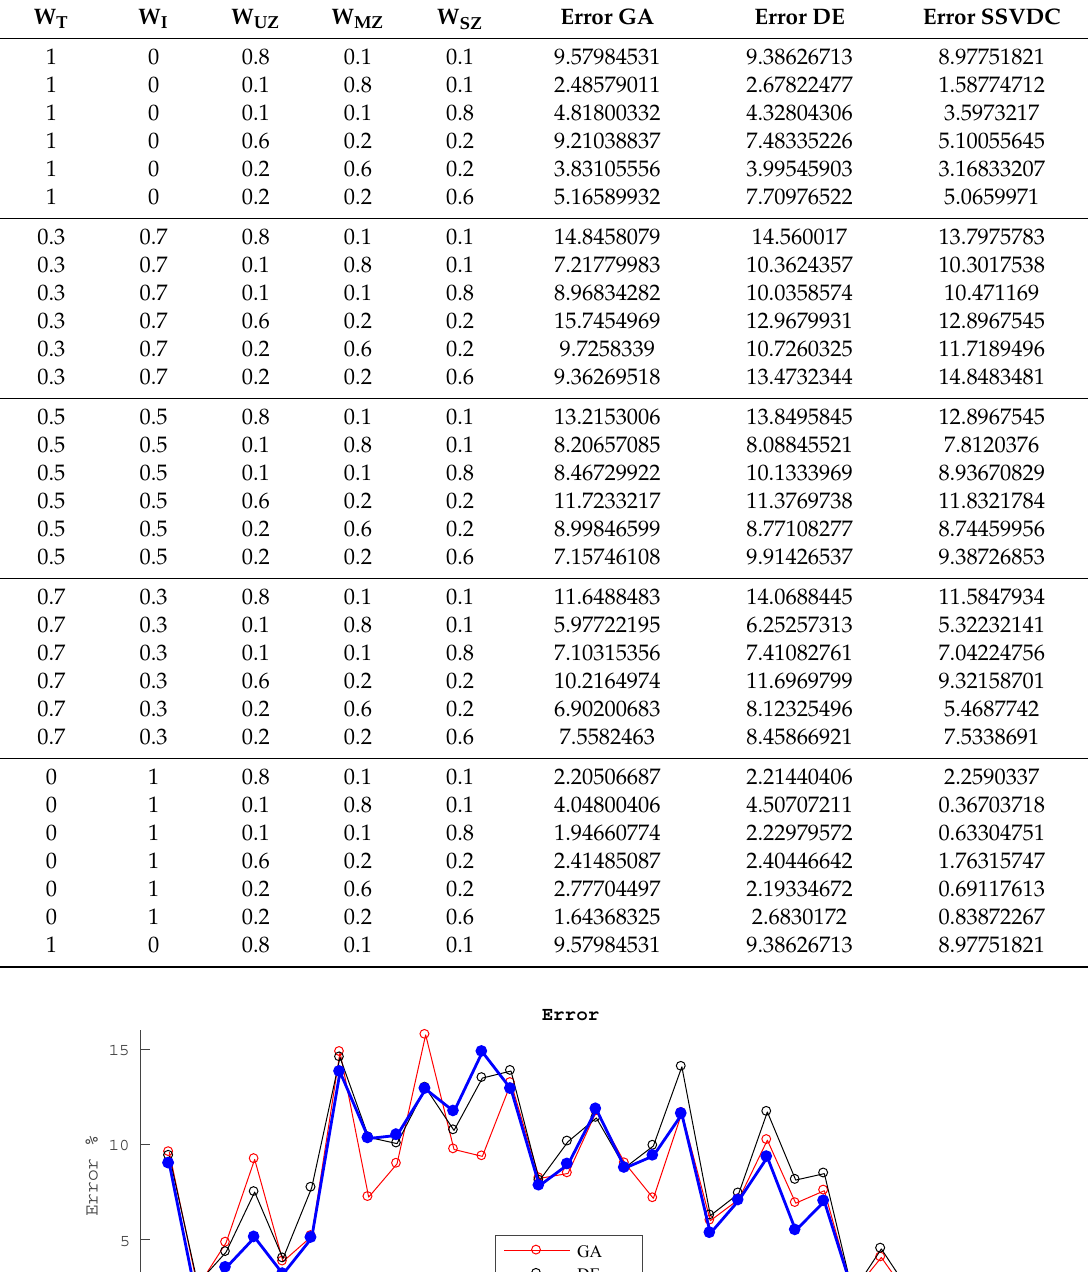
Table 4. Percentage of error obtained by minimizing the error in 30 cases.